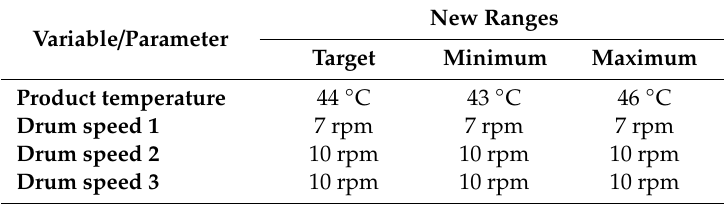
Table 5. Proposed process parameters for the validation batches.